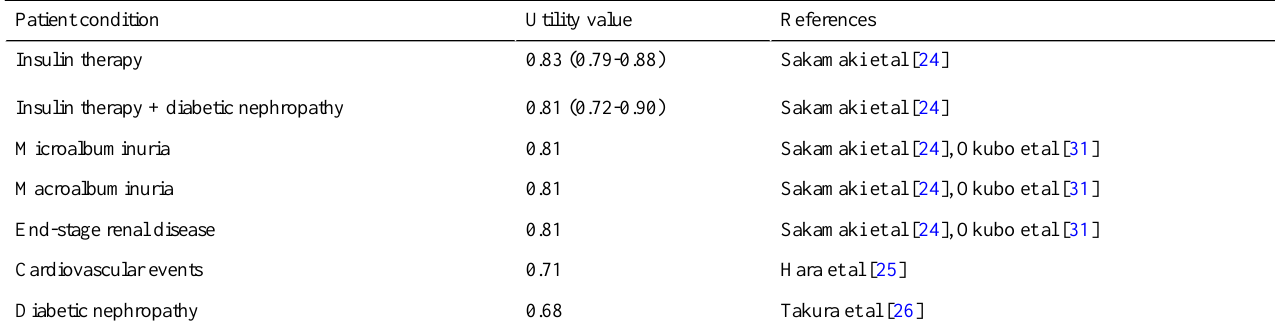
Table 2. Utility value of each patient